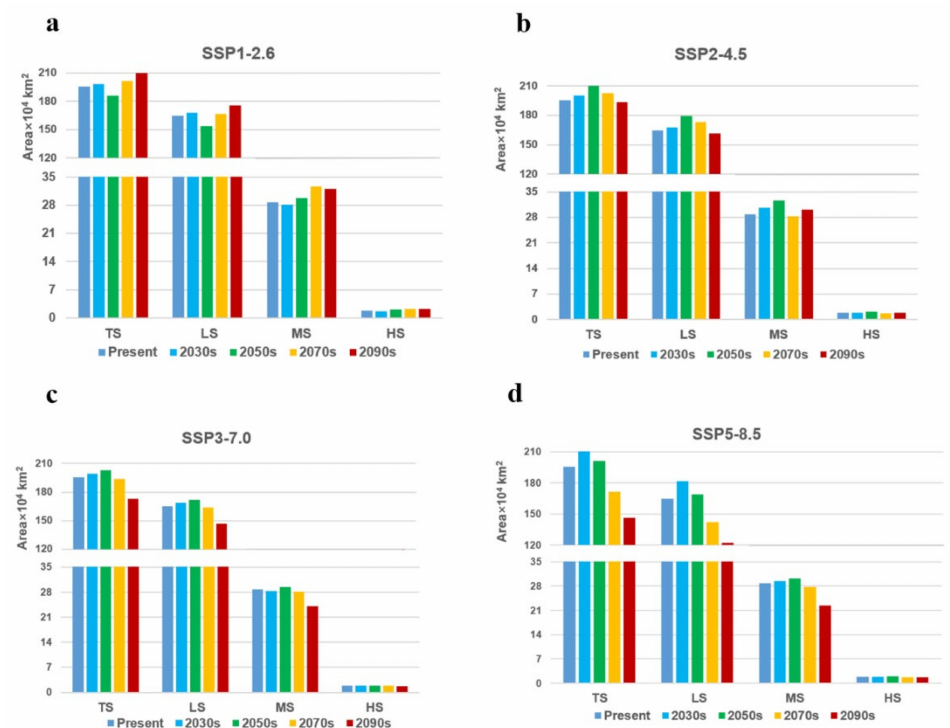
Figure 6. Present and future (2030s, 2050s, 2070s, and 2090s) suitable habitat area under four climate scenarios: ( a ) SSP1–2.6, ( b ) SSP2–4.5, ( c ) SSP3–7.0, and ( d ) SSP5–8.5. TS, LS, MS, and HS represent total suitable, low-suitability, moderately suitable, and highly suitable regions, respectively.